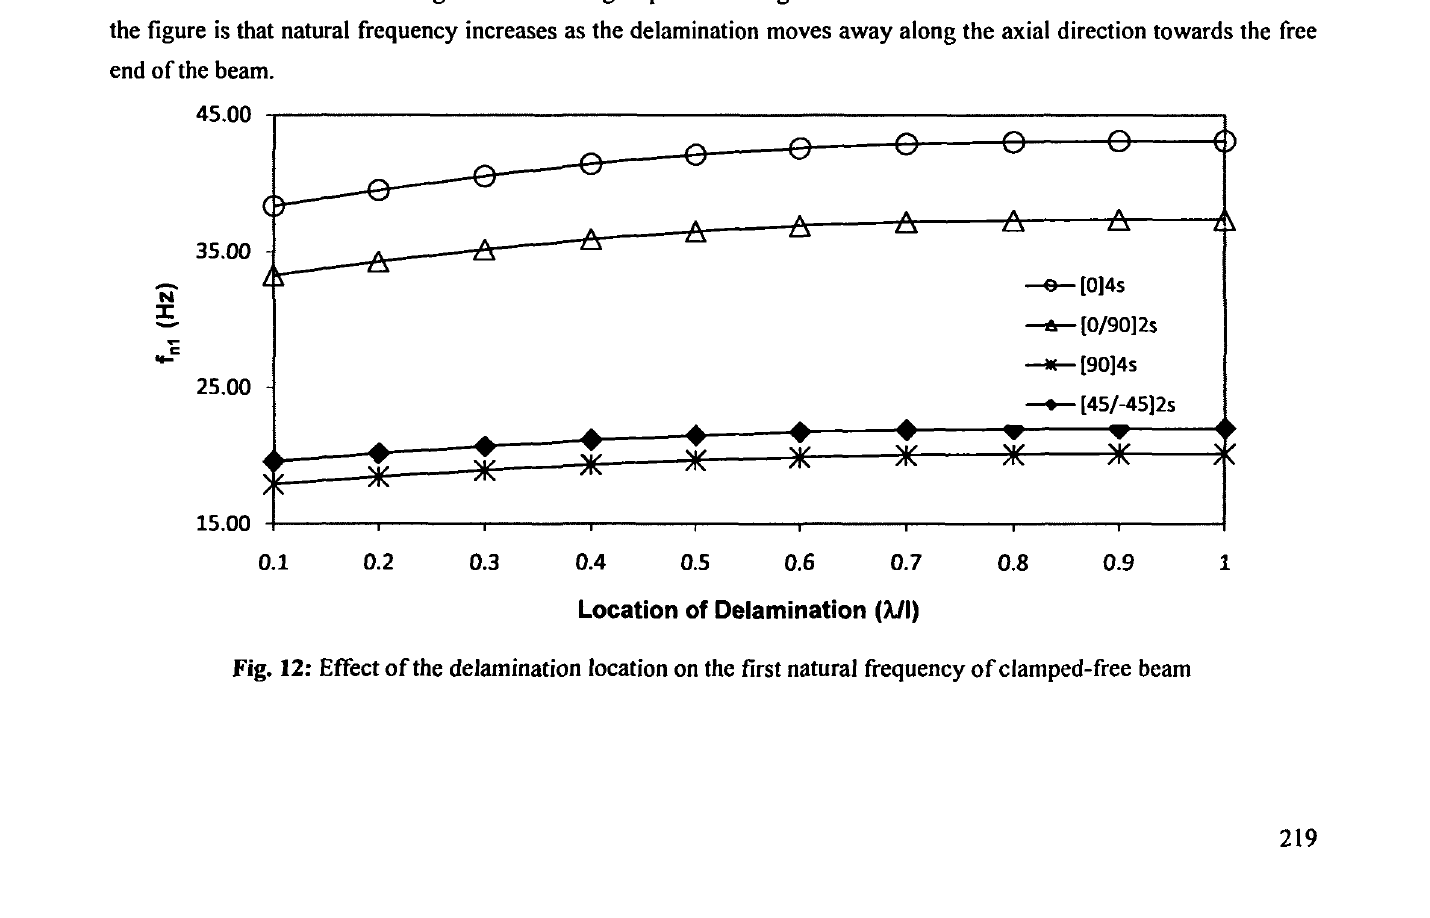
Fig. 12: Effect of the delamination location on the first natural frequency of clamped-free